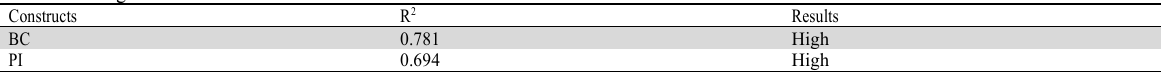
R 2 of the endogenous latent variables Constructs R